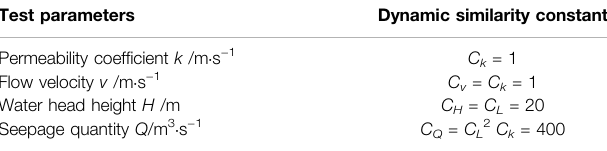
TABLE 4 | Dynamic similarity constants of model tests.